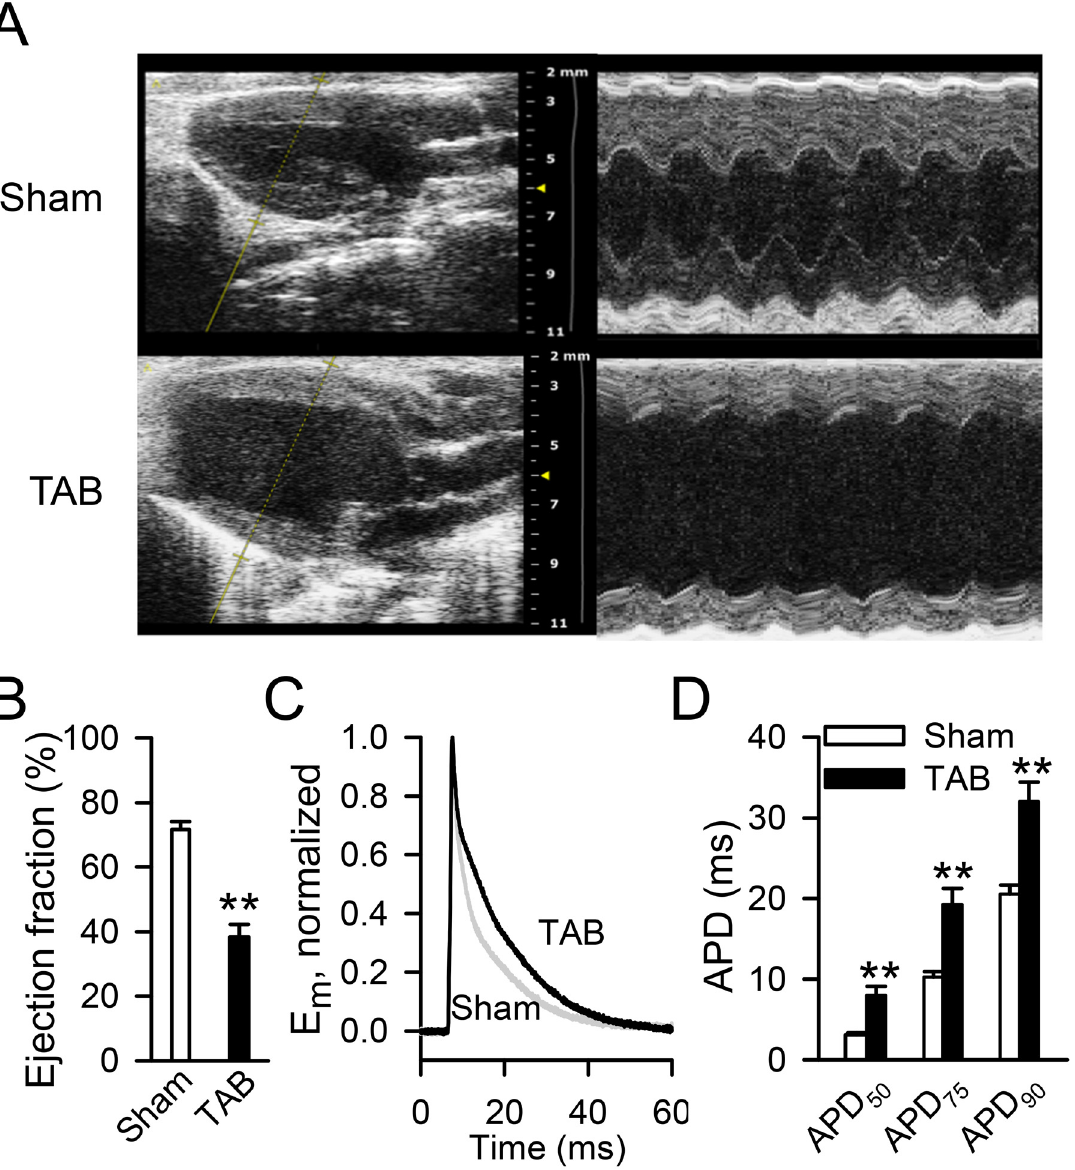
Fig 1. Morphological and electrophysiological changes in transverse aortic banding (TAB) vs . sham operated mice. A) Representative parasternal long axis echocardiographic images of the ventricles of sham and TAB operated mice. B) Summary data of left ventricular ejection fraction ( ** p < 0.01 vs . sham). C) Representative action potentials recorded in isolated ventricular cardiomyocytes from sham and TAB mice. D) Summary data of action potential duration in isolated ventricular myocytes of sham and TAB mice ( ** p < 0.01 vs . sham). APD 50 , APD 75 , APD 90 : action potential duration at 50%, 75% and 90% repolarization, respectively. E m : membrane